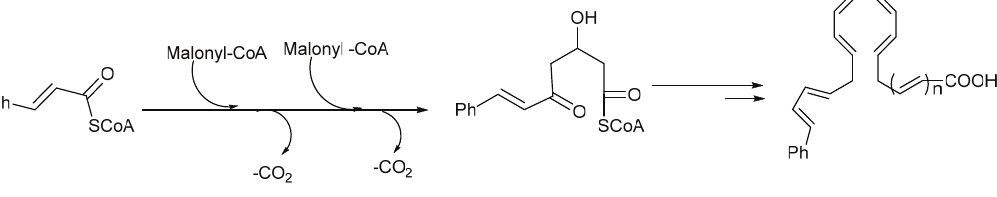
Scheme 1. General biosynthesis scheme of